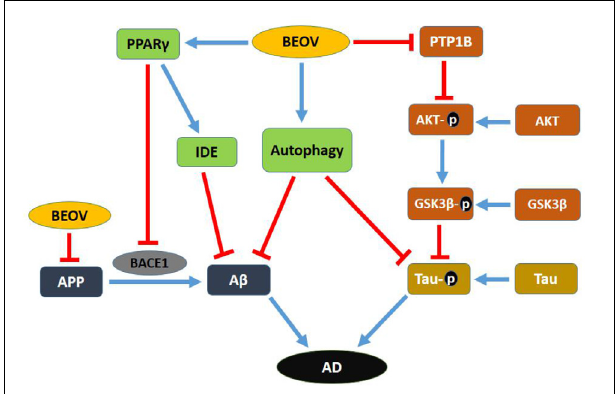
FIGURE 11 | Schematic map of the potential mechanism for the preventive role of BEOV in AD pathology.